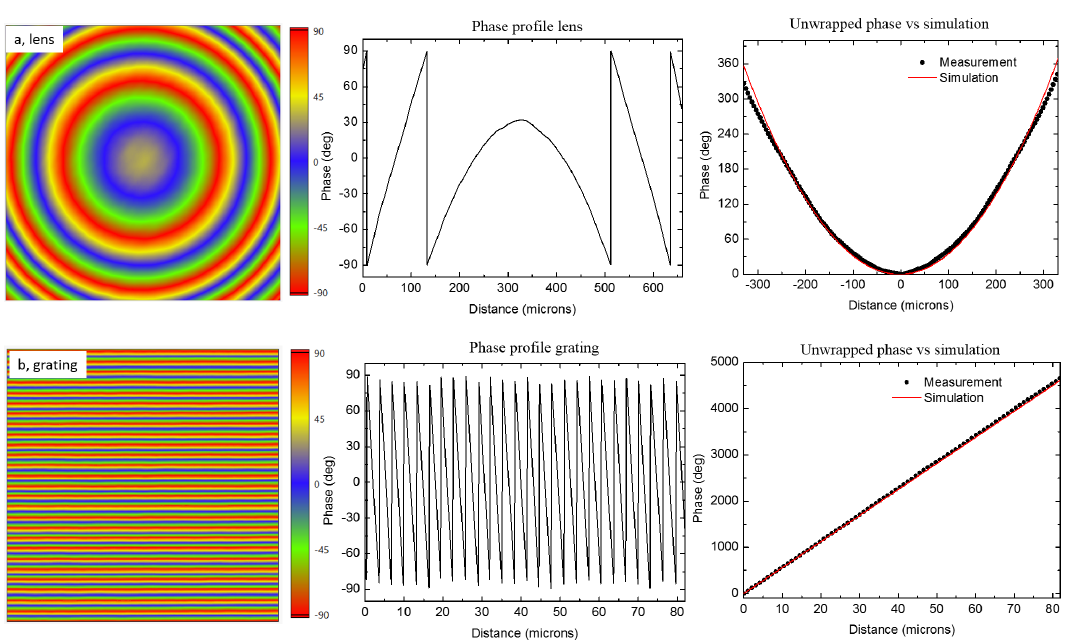
Figure 4. Phase profiles, φ , for the lens ( a ) and the grating ( b ). The left pictures are the space resolved phase images, the central graphs are vertical sections of the phase profiles and the graphs on the right side show the comparison between the unwrapped phases with the simulated